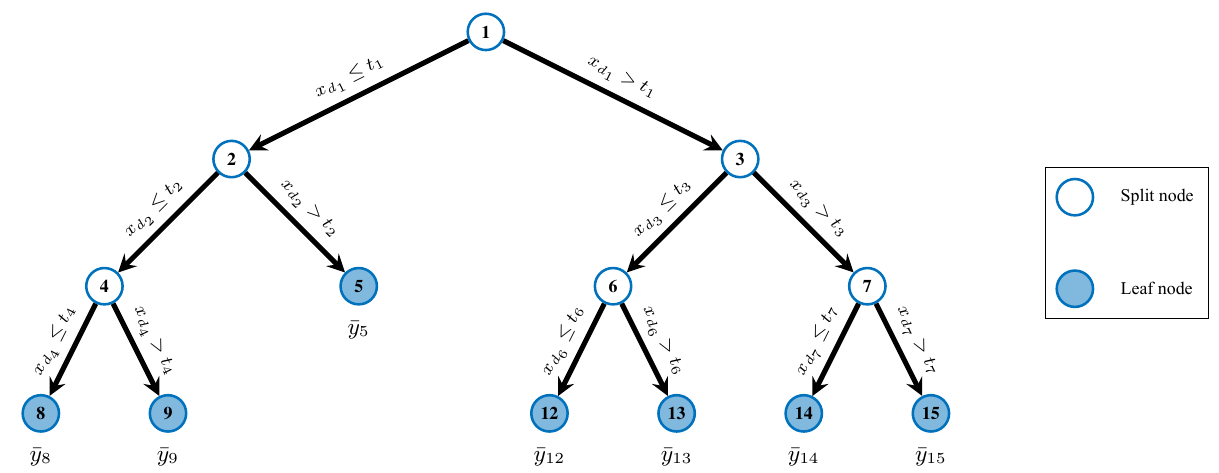
Figure 1. General structure of a decision tree for regression: binary splits with thresholds for individual predictor variables will be used to navigate a sample x to a leaf node that stores a continuous estimate for the target